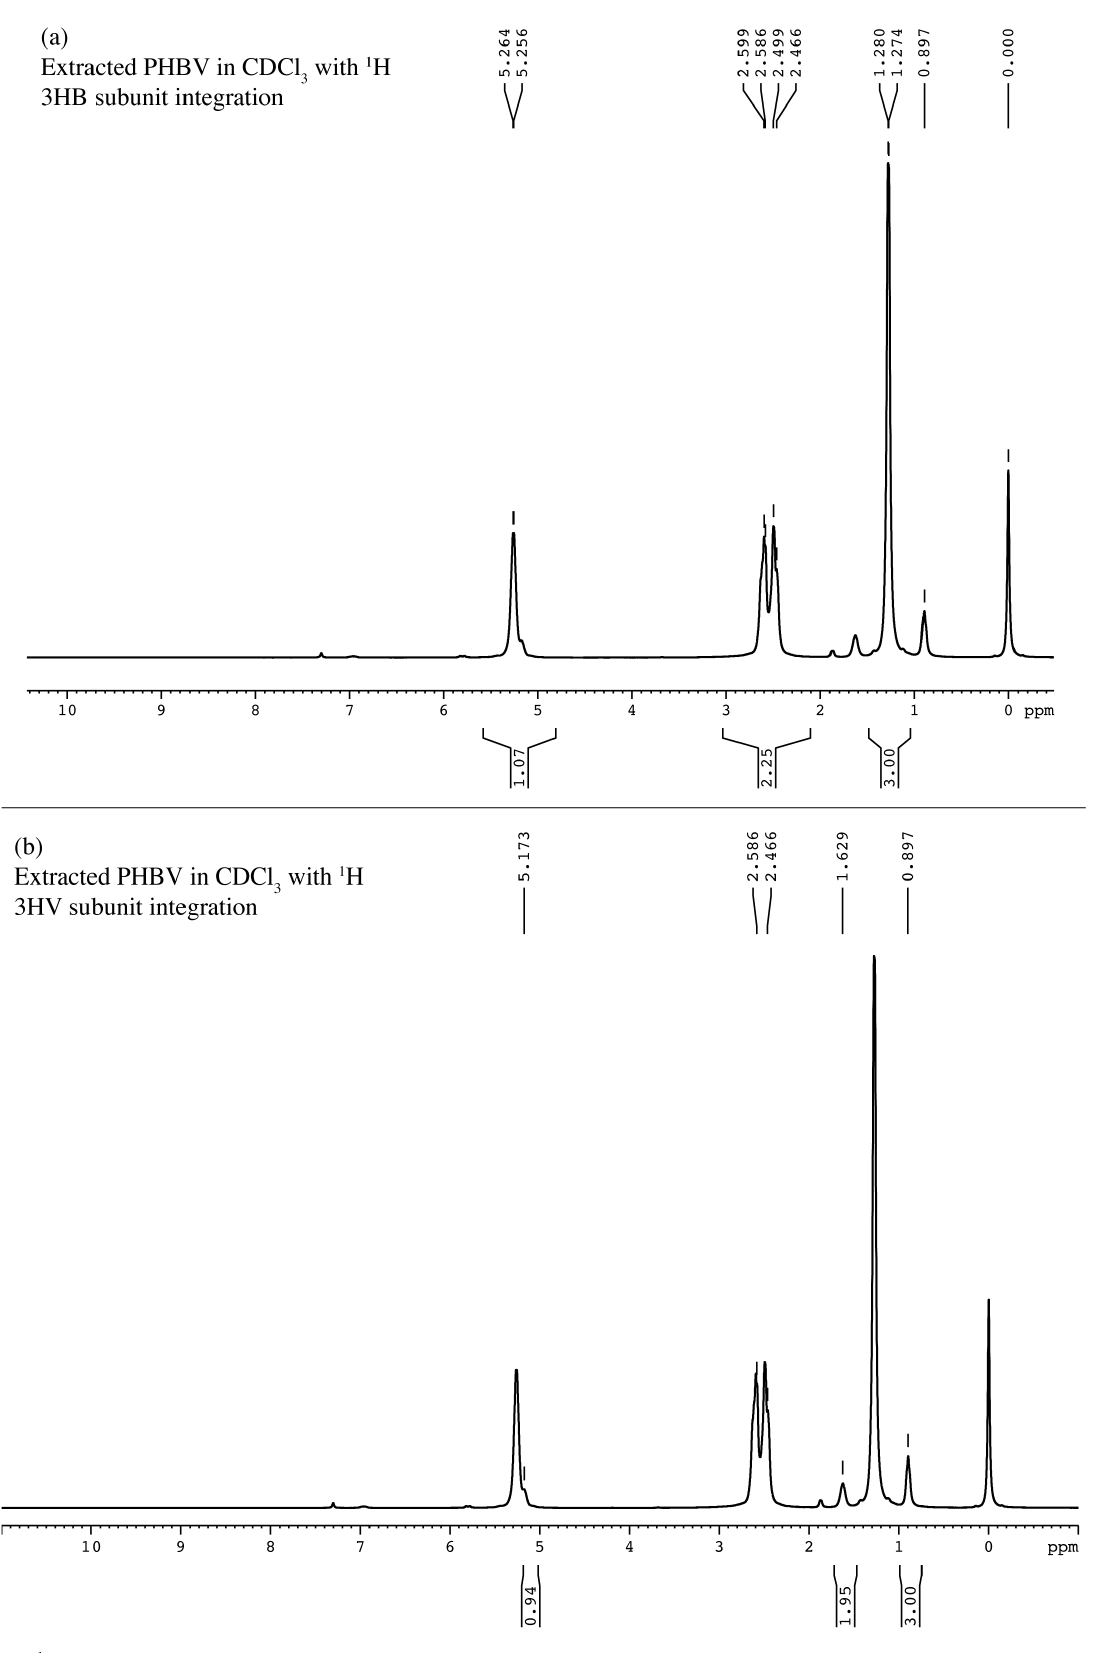
Figure 8. 1 H-NMR spectrum of the PHBV extracted from Cyanosarcina sp. AARL T020: ( a ) 3HB subunit and ( b ) 3HV subunit integrations.